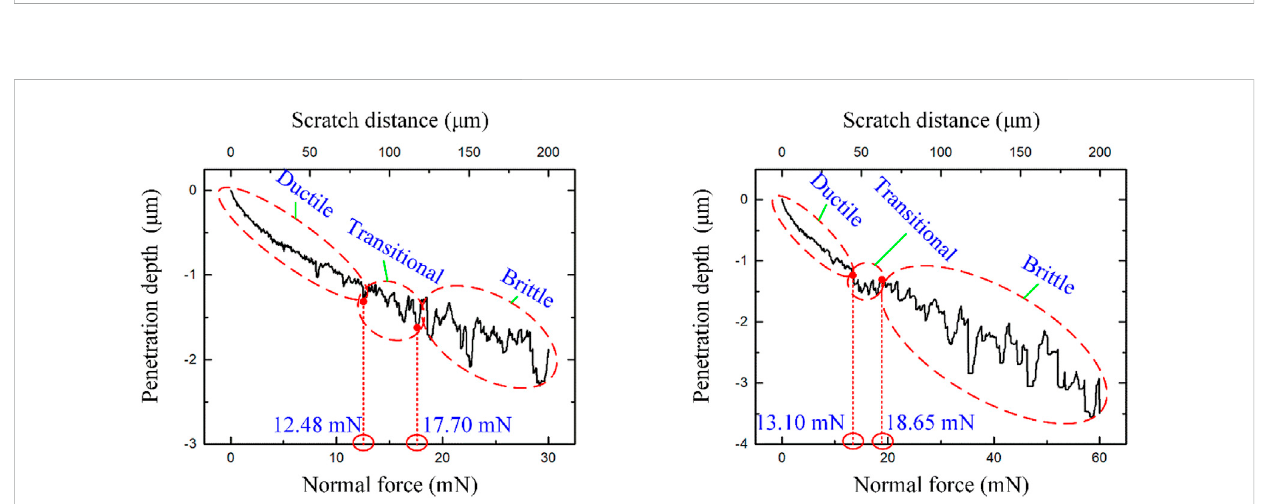
FIGURE 4 The curve of penetration depth versus scratch distance/normal